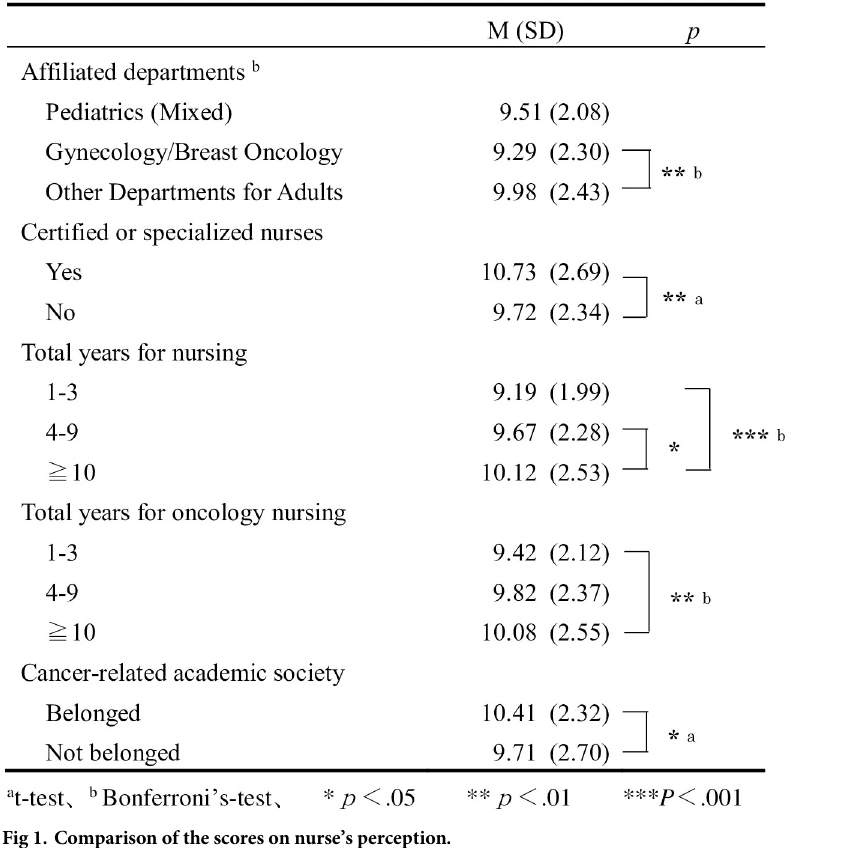
Fig 1. Comparison of the scores on nurse’s